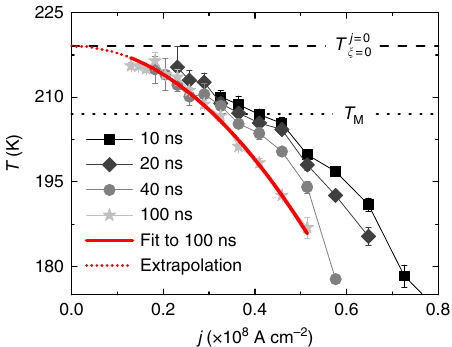
Fig. 3 Temperature of H x independence at various current densities. T at which ξ = 0 versus current density j for 10 ns, 20 ns, 40 ns and 100 ns long voltage pulses. Fit to data of 100 ns long pulses used to obtain temperature T j ¼ 0 ξ = 0 in the limit of no heating by extrapolation of fi t. Error ξ ¼ 0 at which bars re fl ect errors in T j ξ ¼ obtained by fi ts to data (Fig. 2c 0